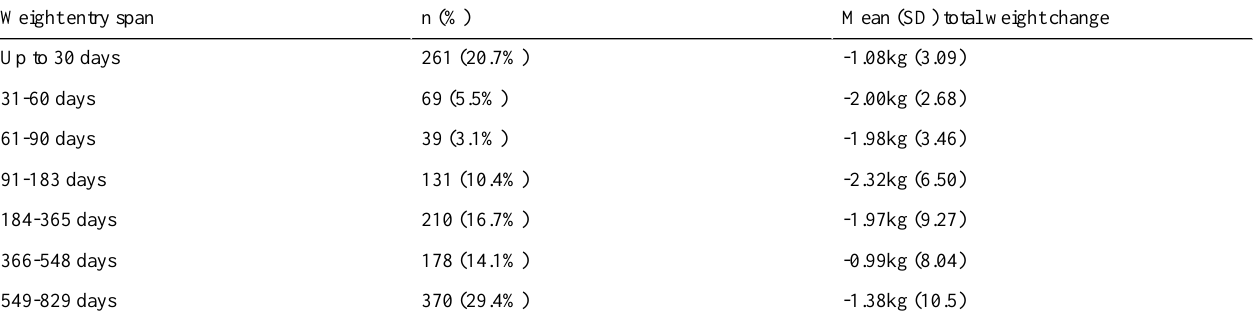
Table 3. Total weight change stratified by weight entry span a among final cohort